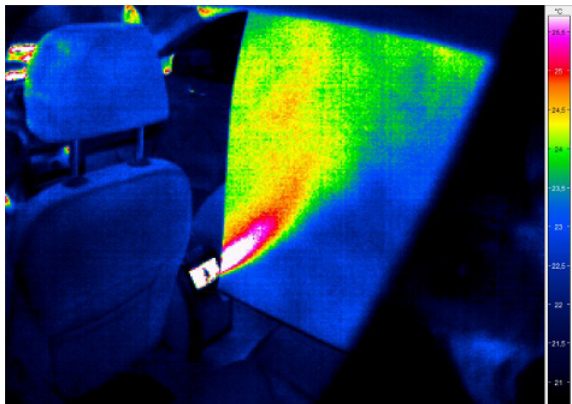
Fig. 7. The thermogram of measured temperature field in 2D hot airstream at rear row of seats from the infrared camera on the tripod stand